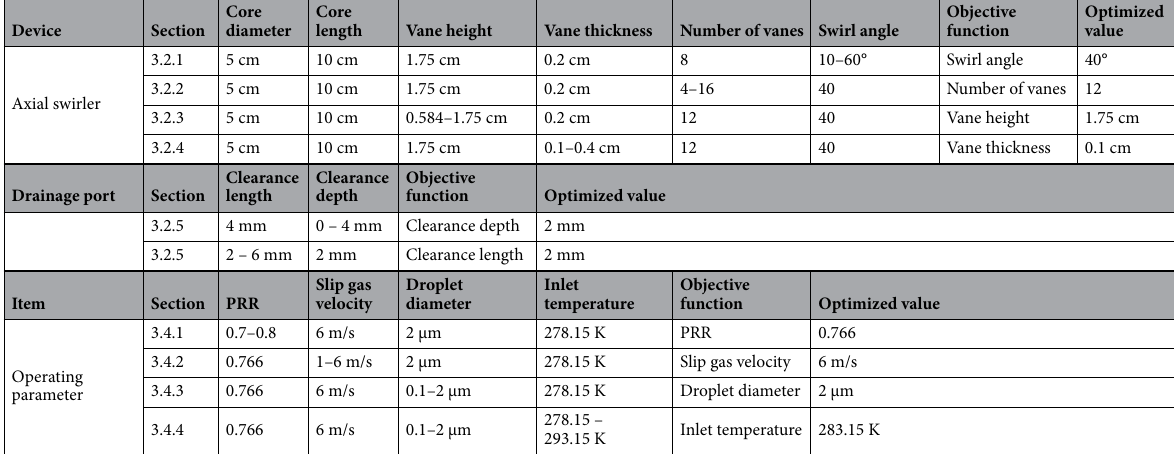
Table 4. Summary of optimizations performed in different